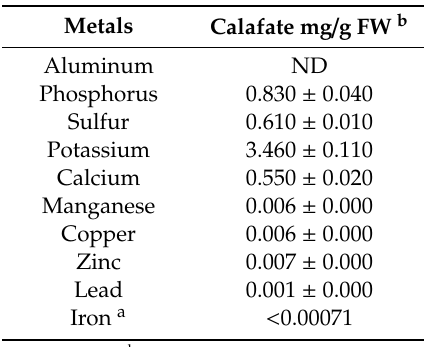
Table 3. Estimated concentration of metals in calafate berry by TXRF.